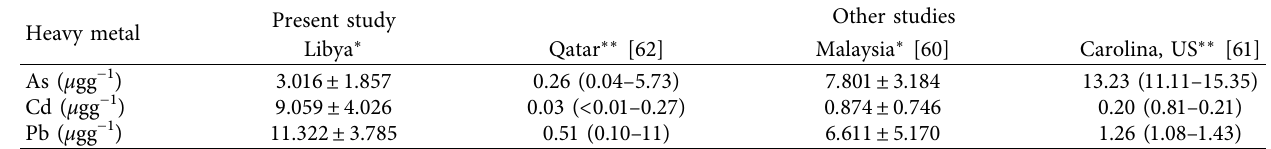
Table 12: Meta-analysis of heavy metals (As, Cd, and Pb) levels in farmers’ fingernail samples. Heavy